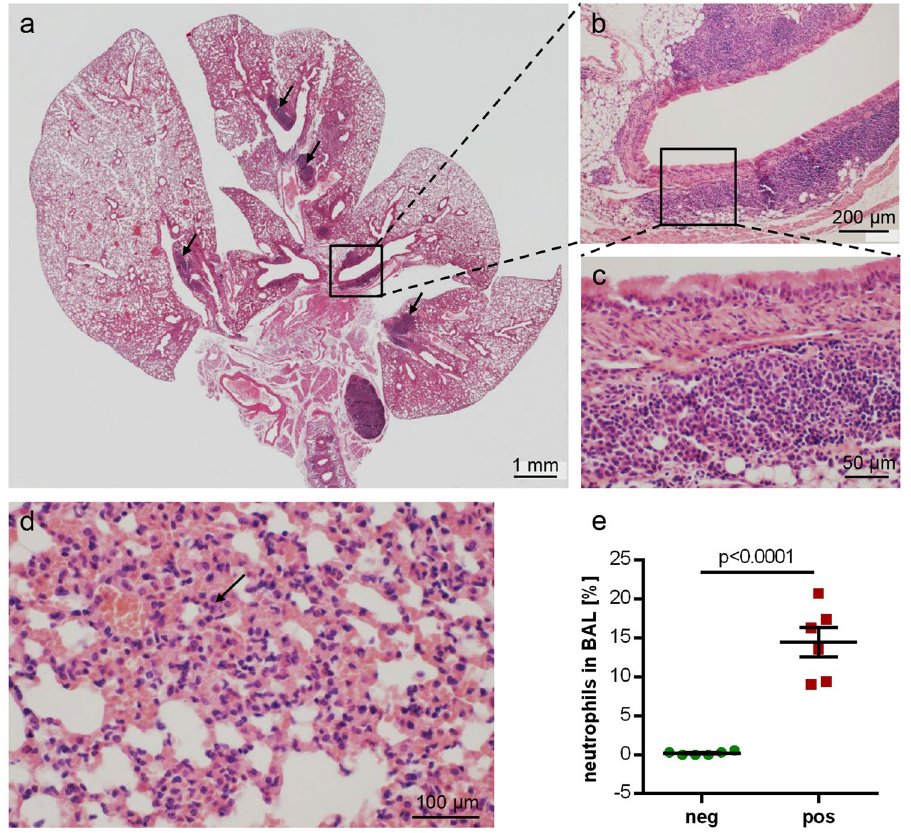
Figure 4. Lung histopathology in B. pseudohinzii -infected mice. ( a–d ) H&E-stained paraffin section; ( c ) and ( b ) represent higher magnifications of boxed areas in ( b ) and ( a ), respectively, demonstrating BALT aggregates; additional BALT is indicated by arrows in ( a ). The lung section depicted in a–c is taken from an animal which was also positive for Pasteurella pneumotropica . ( d ) Interstitial pneumonia with neutrophils ( arrow ). ( e ) The incidence of neutrophils is significantly elevated in the BAL fluid from B. pseudohinzii -positive (pos; n = 6) compared to B. pseudohinzii -negative mice (neg; n = 6) (mean ± SEM; Student’s unpaired